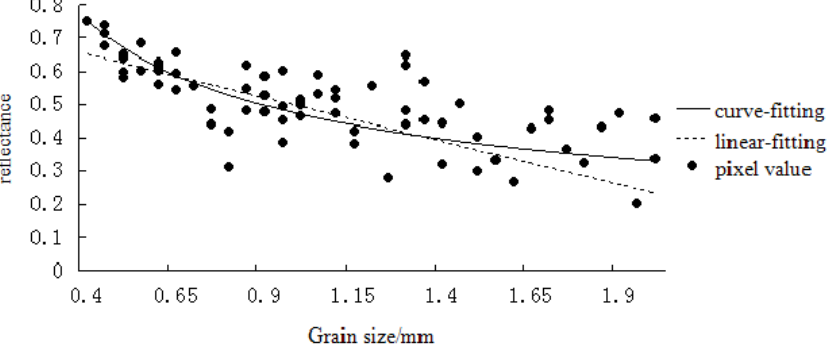
Figure 11. The relationship between the snow grain size and reflectance at band 89.